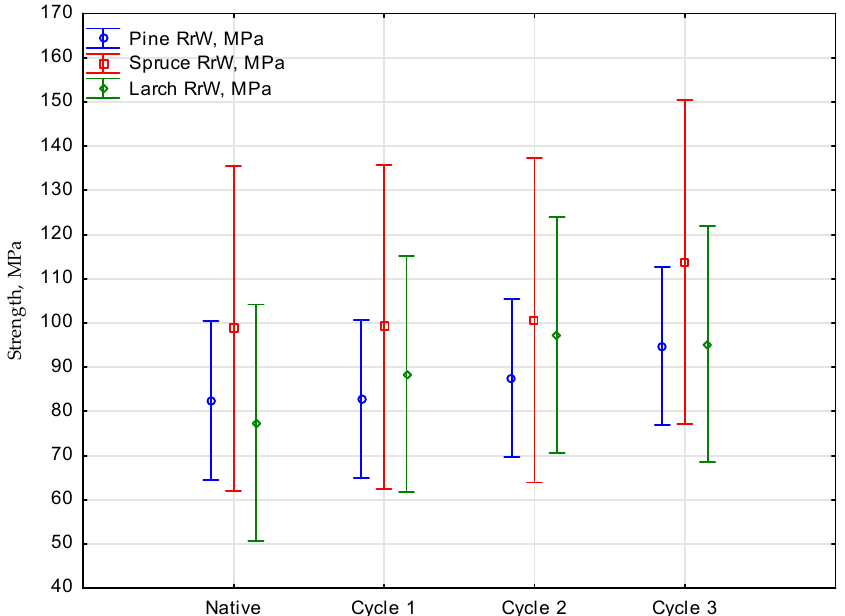
Figure 4. Effect of the number of salinated water soaking cycles on the tensile strength values of a given wood species.